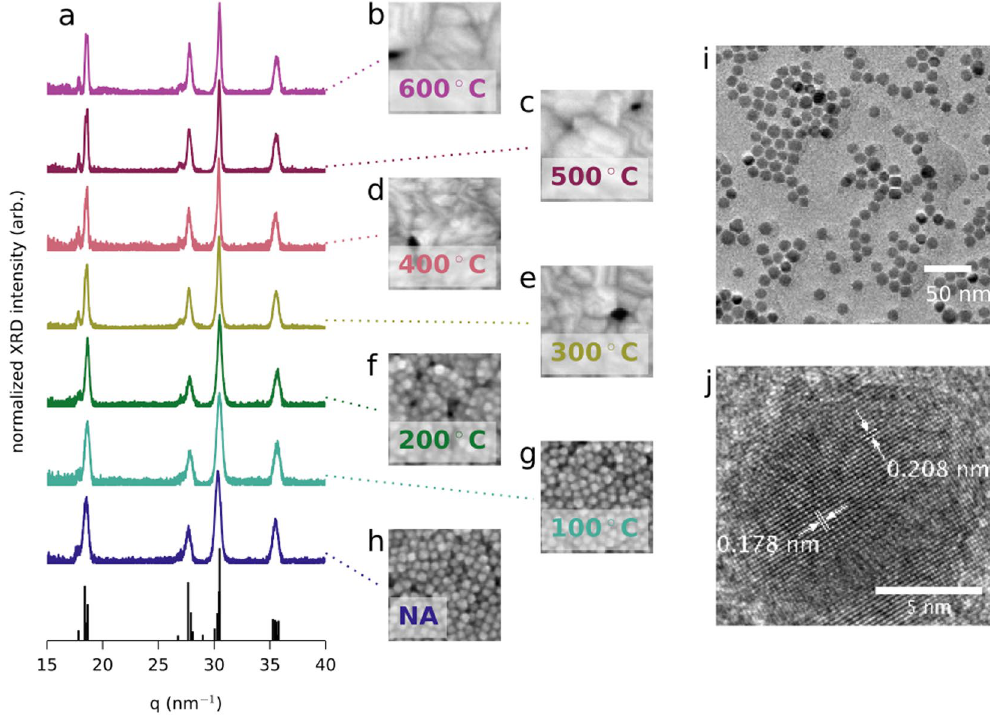
Figure 1. Nanocrystal structural characterization. ( a ) XRD spectra for drop-cast and annealed films of Cu 2 Se. In this plot, q is in units of 2 π / d . The reference peaks are calculated from the room temperature structure determined by Gulay et al . 37 . ( b–h ) Top-view SEM images of thin films that were annealed at the same temperature as the drop-cast samples used for XRD spectra in ( a ). In panel ( h ), “NA” stands for “not annealed”. Each image is 170 nm across. ( i ) Low resolution TEM image of Cu 2 Se nanocrystals. ( j ) High resolution TEM image of a Cu 2 Se nanocrystal.